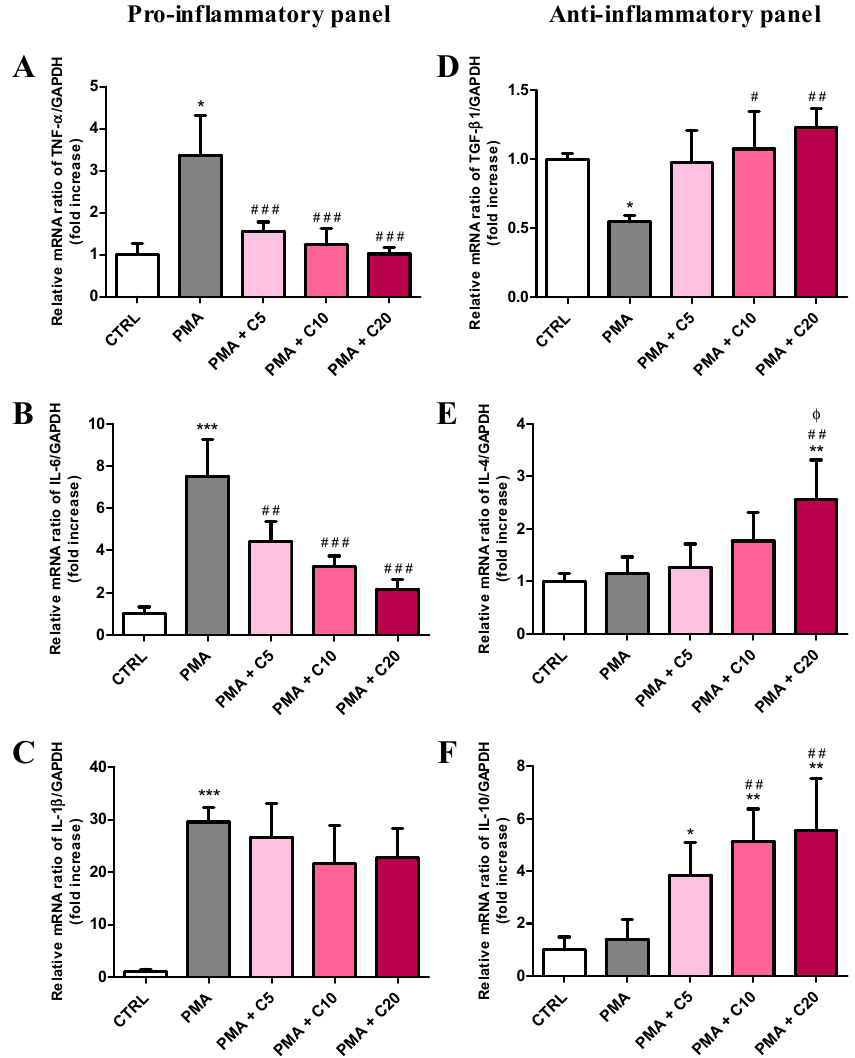
Figure 5. Measurement of ( A ) TNF- α , ( B ) IL-6, ( C ) IL-1 β , ( D ) TGF- β 1, ( E ) IL-4, and (F) IL-10mRNA expression levels (qRT-PCR) in resting (control) macrophages and in macrophages stimulated with PMA and SOD inhibitors, in absence or presence of increasing concentrations (5, 10, or 20) of carnosine. GAPDH-mRNA and NTC reactions were used as internal and negative controls, respectively, as described in Figure 4. Values are means ± SD of three to seven independent experiments. * p < 0.05 vs. CTRL; ** p < 0.01 vs. CTRL; *** p < 0.001 vs. CTRL; # p < 0.05 vs. PMA; ## p < 0.01 vs. PMA; ### p < 0.001 vs. PMA; ϕ p < 0.05 vs. PMA + C5. Compared to control cells (Figure 5A–C), PMA treatment significantly increased the expression levels of TNF- α (+3.36-folds, p < 0.05), IL-6 (+7.51-folds, p < 0.001), and IL-1 β (+29.56-folds, p < 0.001). Carnosine decreased TNF- α levels in a concentration-dependent manner ( p < 0.001 vs. PMA for all carnosine concentrations) up to values equaling those found in controls, when carnosine was used at 10 or 20 mM. A similar trend was observed in the case of IL-6 ( p < 0.01 vs. PMA for PMA + C5 and p < 0.001 vs. PMA for PMA + C10 or C20), although IL-6 expression was higher than control even in presence of 20 mM carnosine. Unlike TNF- α and IL-6, carnosine treatment did not significantly decrease the remarkable increased in IL-1 β mRNA expression induced by PMA ( p < 0.001 vs. CTRL). Significant decrease in the expression levels of TGF- β 1 was recorded after the challenge of